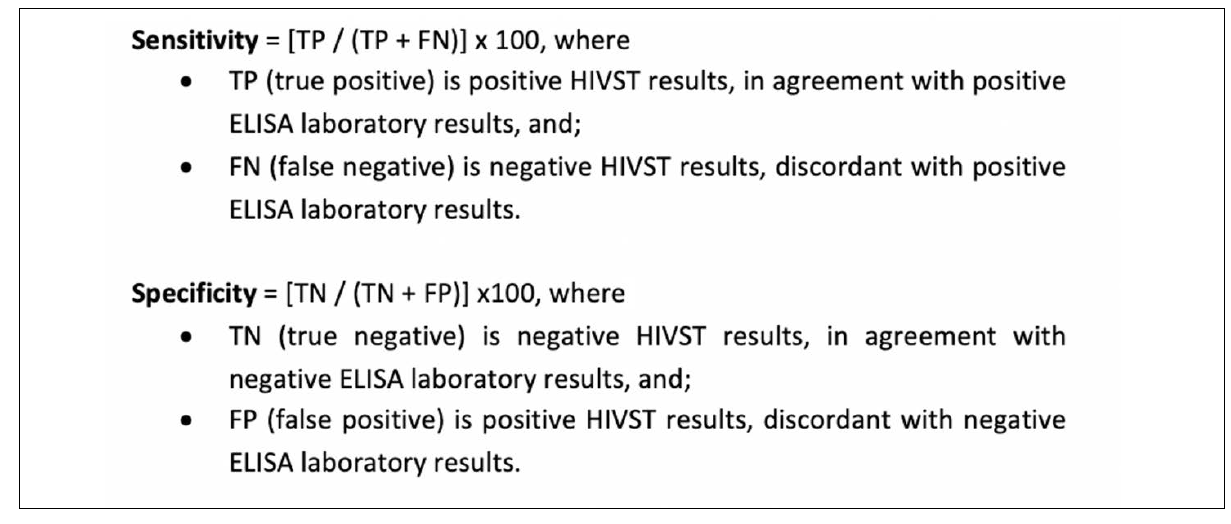
Figure 1: Sensitivity and specificity